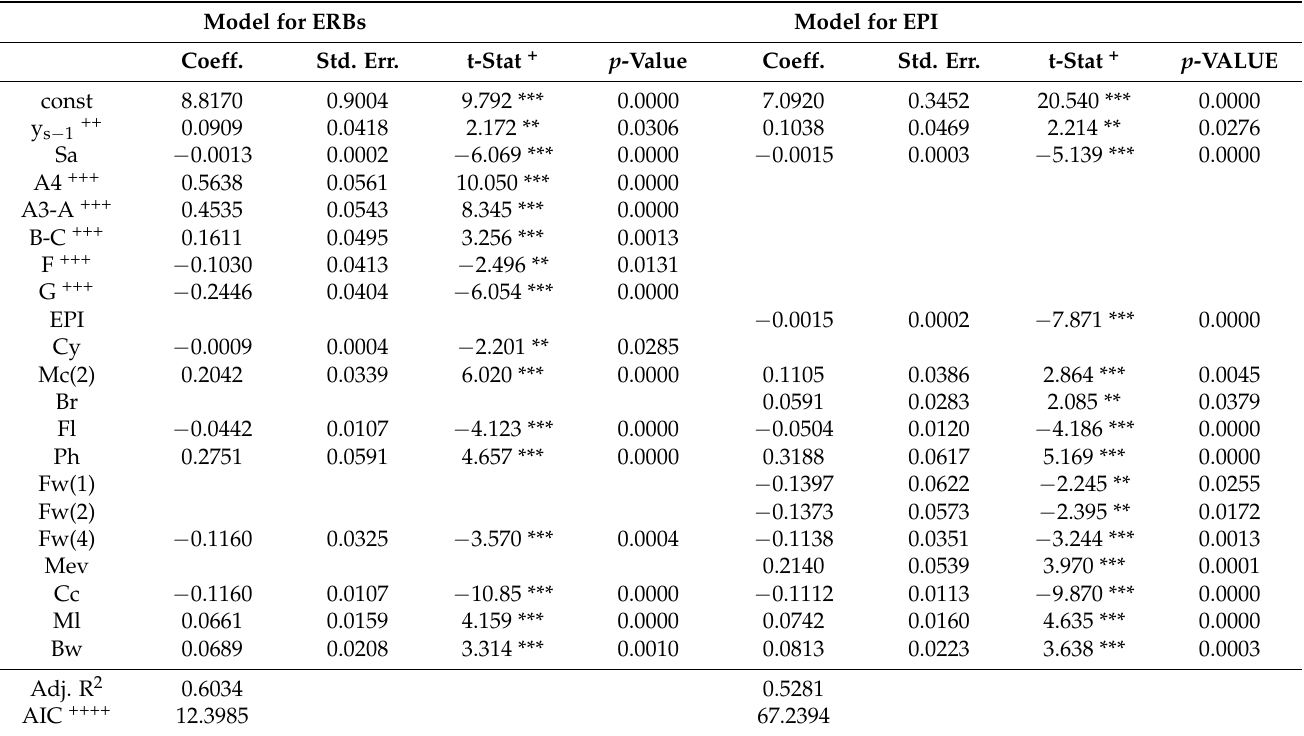
Table 2. Results for the spatial autoregressive